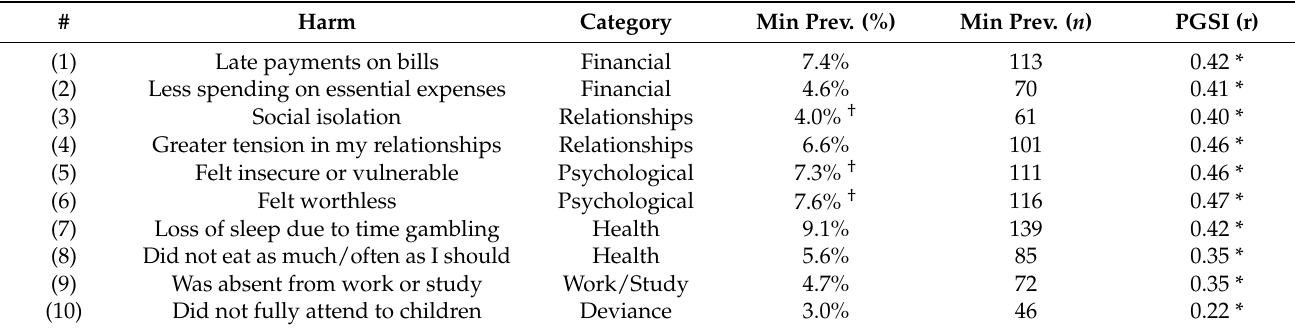
Table 2. “Unimpeachable” gambling harms scale (UGHS) items. Category of harm, minimum single-sample prevalence, and Pearson’s correlations (r) with PGSI scores are